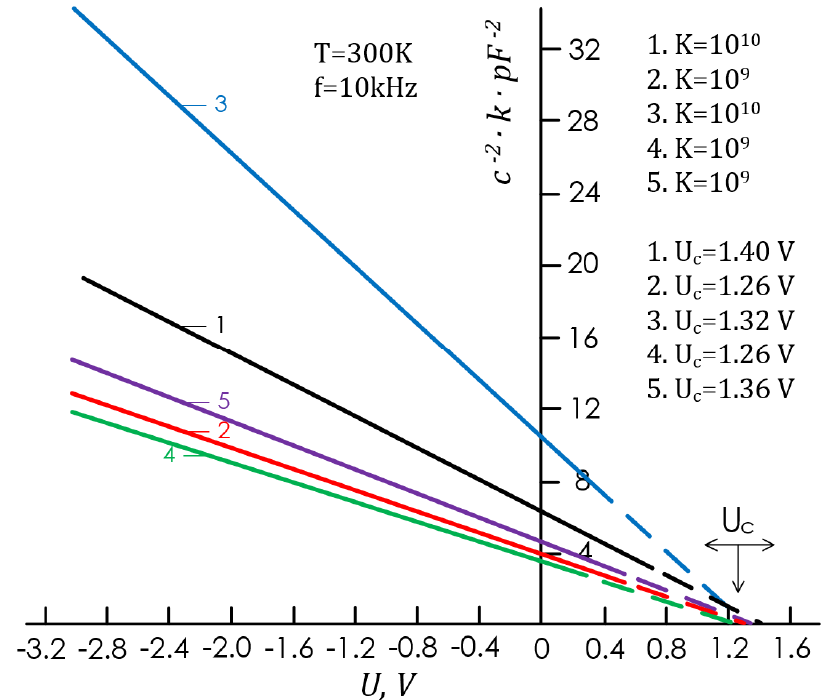
Figure 3. The differential capacitance dependence on the bias voltage of Au-Pd-n-GaP SB with various thicknesses of intermediate palladium layer d: 1—40 Å ( β = 1.35); 2—32 Å ( β = 1.28); 3—45 Å ( β = 1.39); 4—22 Å ( β = 1.19); 5—29 Å ( β = 1.25).